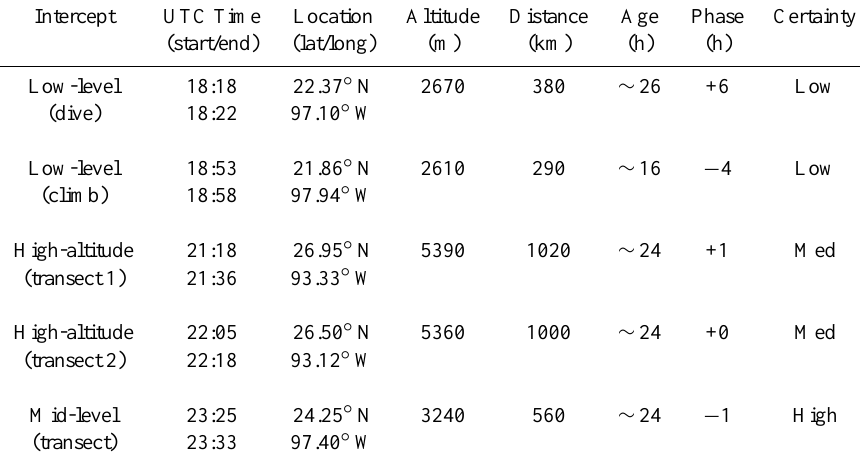
Table 2. Summary of long-range MCMA transport pathways intercepted by the C-130 on 19 March. For each intercept, the table gives the time range (rounded to the nearest minute), the median latitude, longitude, altitude, distance from the center of MCMA, and the approximate plume age based on the computed trajectories. The phase mismatch column specifies the number of hours by which the C-130 led (positive) or lagged (negative) the trajectories in arriving at the intercept location. Intercepts with the lowest phase mismatch and largest number of wind measurements have the greatest certainty (far right